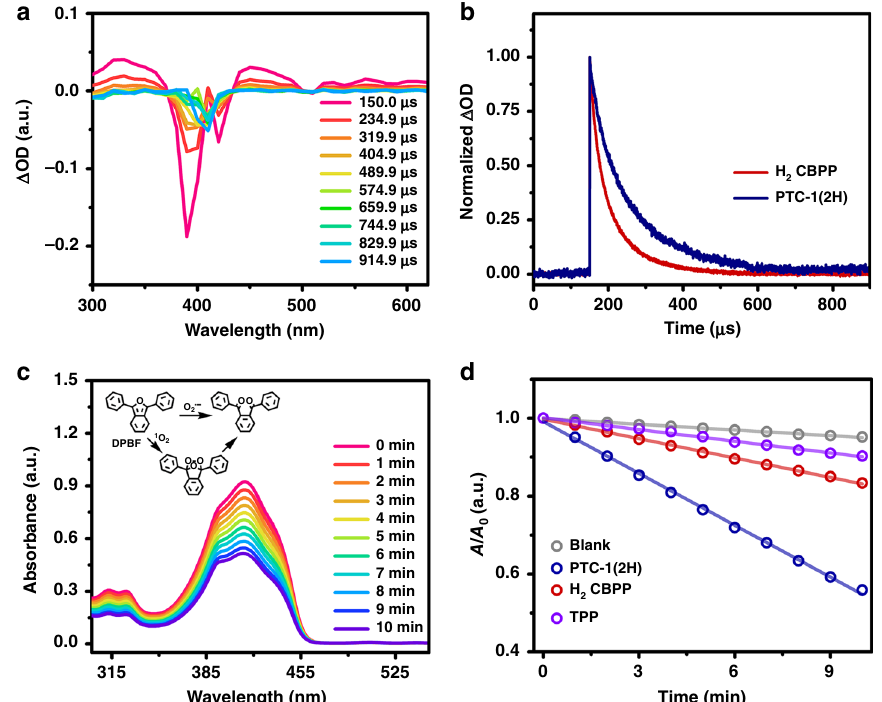
Fig. 4 Homogeneous photophysical and photocatalytic behaviors of PTC-1(2H). a Nanosecond transient absorption spectra for a toluene solution of PTC-1(2H) excited upon 355 nm laser pulse under nitrogen condition; b normalized kinetic traces of the 450 nm band of PTC-1(2H) and H 2 CBPP under nitrogen condition; c time-dependent absorption spectra of DPBF in DMF upon visible light irradiation ( λ > 510 nm) in the presence of PTC-1(2H); d comparison of absorbance decay rate at 416 nm of DPBF in the presence of different catalysts. Source data are provided as a Source Data fi le.